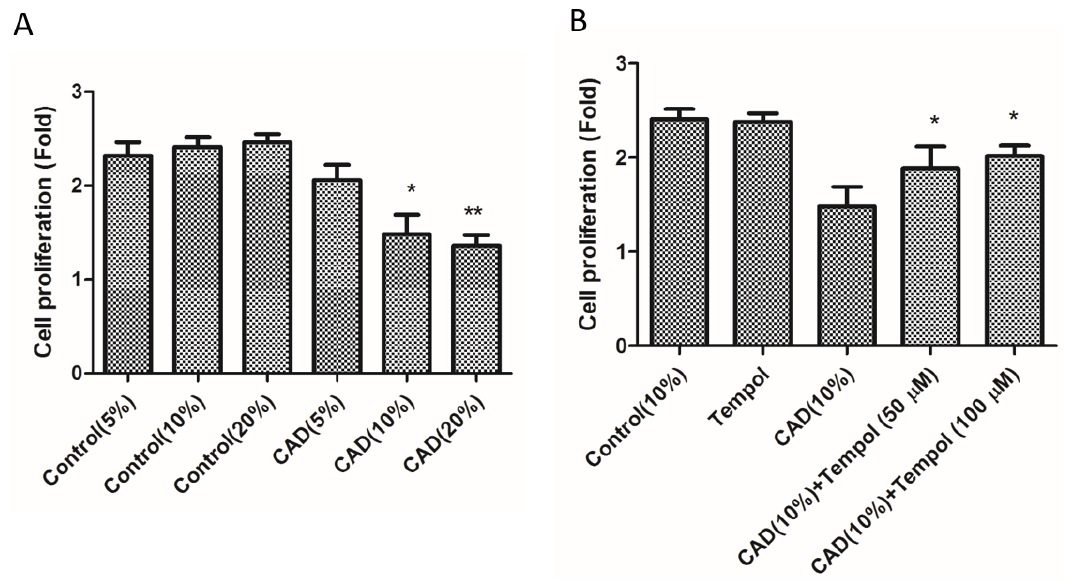
Figure 1: Effects of CAD serum on HUVEC proliferation. (A) HUVECs were cultured in 96-well plates with different concentrations of CAD serum, and cell proliferation was assessed by MTT assay. (B) HUVECs were cultured in 96-well plates with 10% CAD serum for 24-72 h, and cell proliferation was assessed by a CCK8 assay. (C) HUVECs were cultured in 96-well plates with 10% CAD serum+ tempol (50 or 100 µM) for 24 h, and cell proliferation was assessed by a CCK8 assay. *p<0.05, **p<0.01 vs. Control